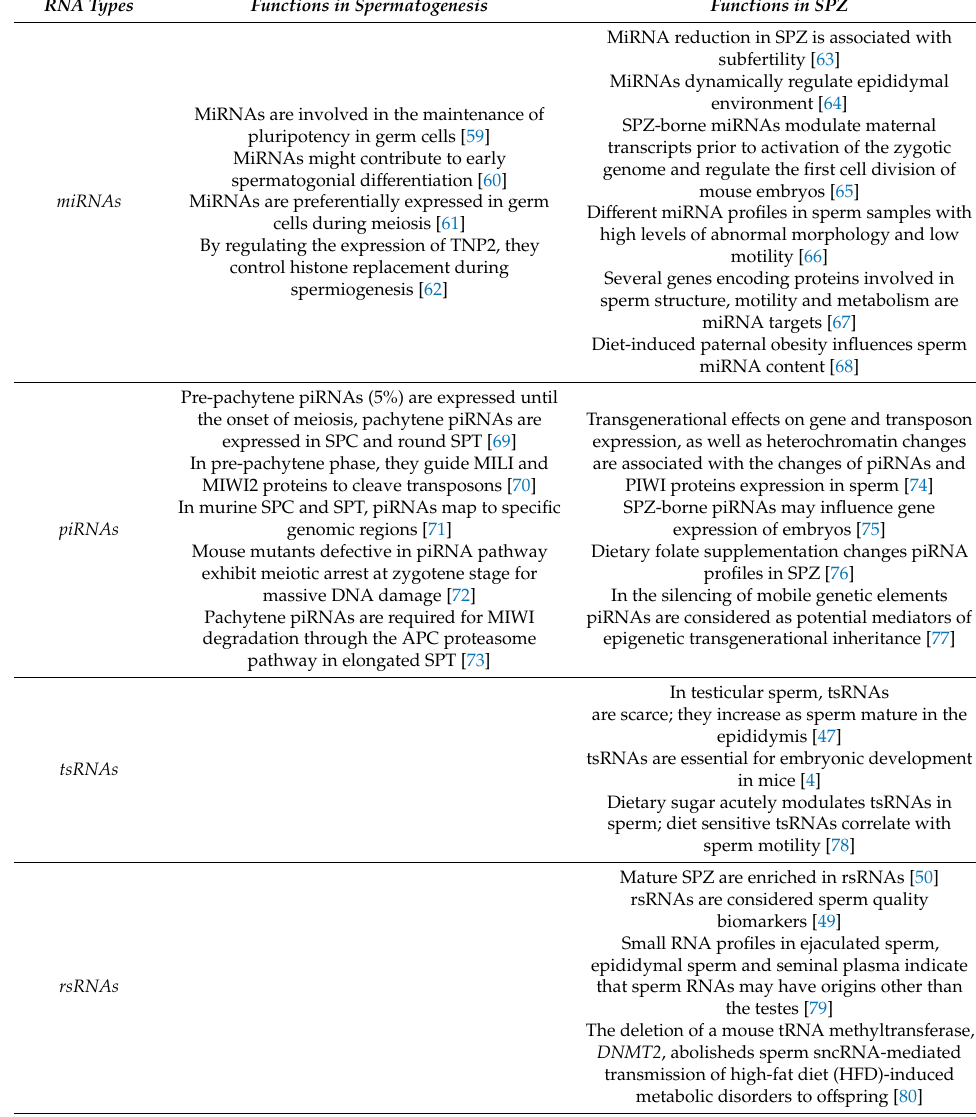
Table 2. The main functions of sperm RNA types in spermatogenesis and